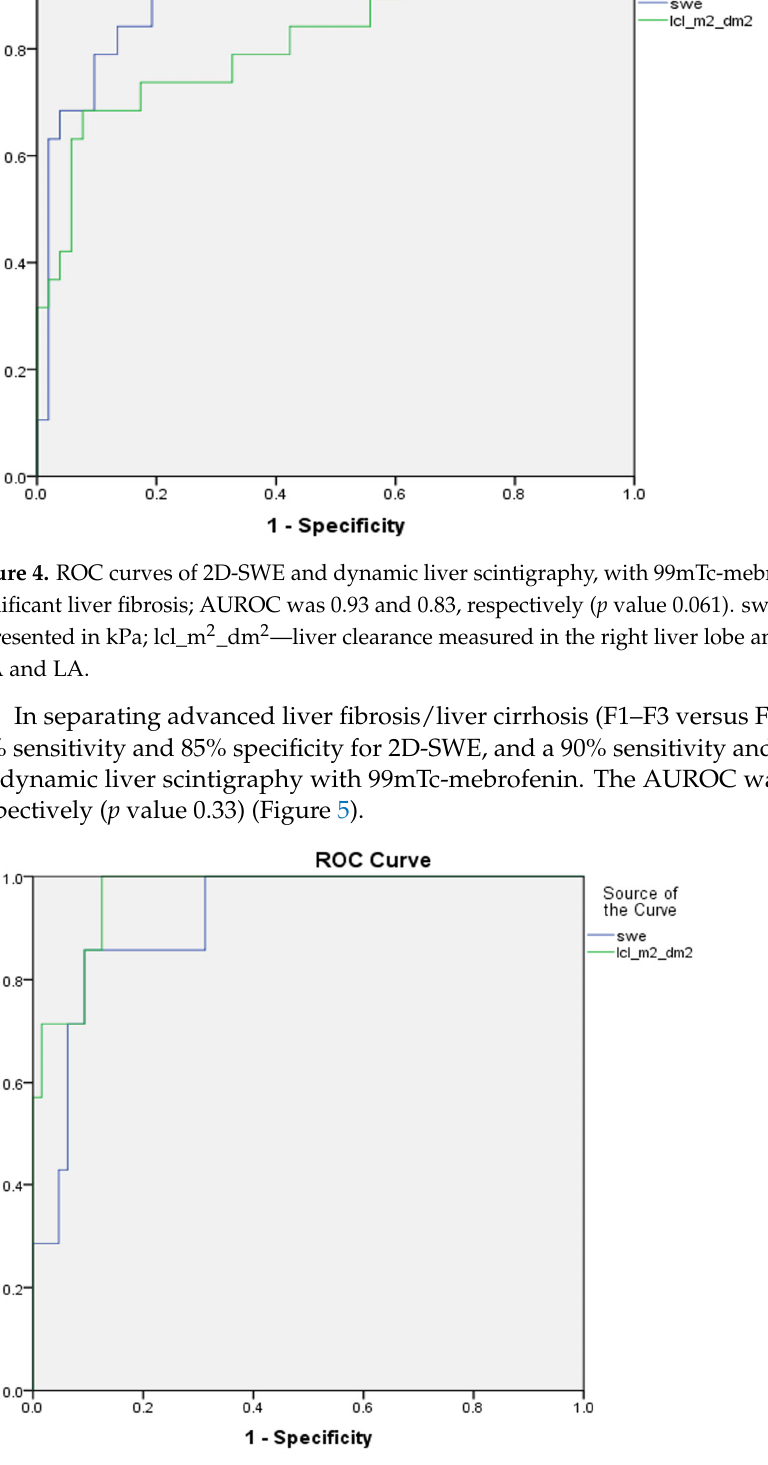
Figure 5. ROC curves of 2D ‐ SWE and dynamic liver scintigraphy, with 99mTc ‐ mebrofenin separat ‐ ing liver cirrhosis; AUROC was 0.91 and 0.96, respectively ( p value 0.33). swe—2D ‐ SWE value, represented in kPa; lcl_m 2 _dm 2 —liver clearance measured in right liver lobe and corrected using BSA and LA.